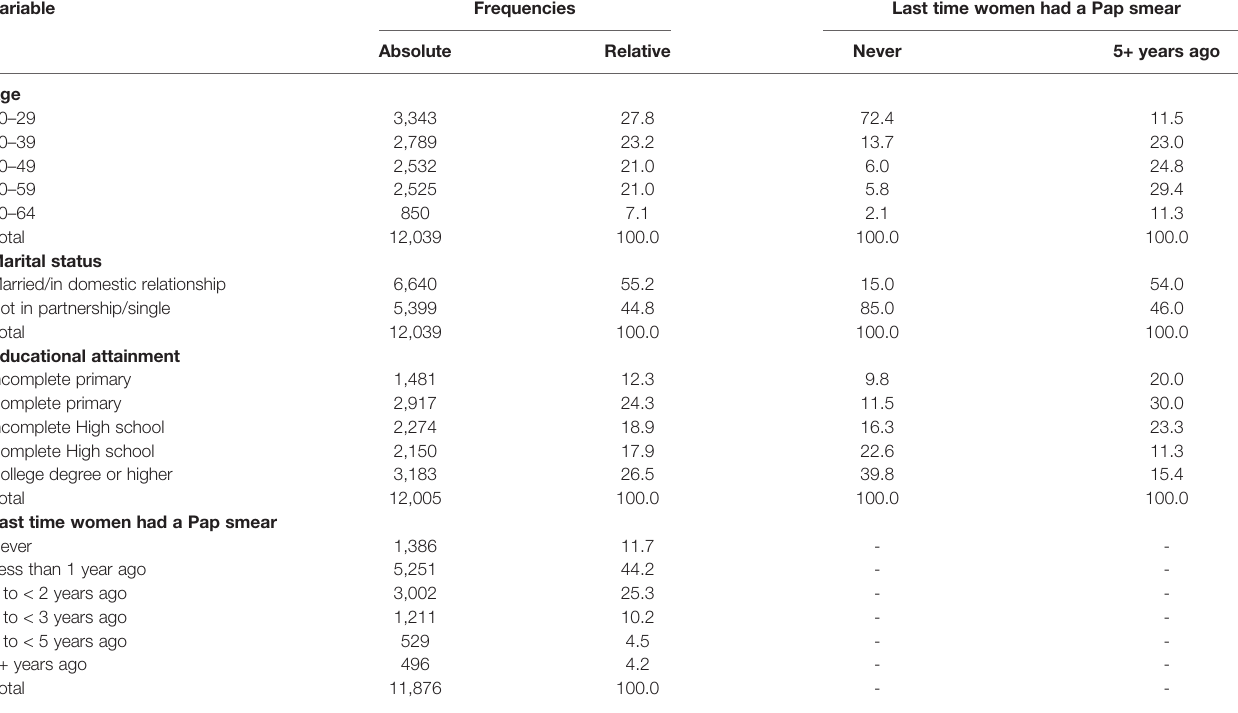
TABLE 1 | Descriptive information of the study population.